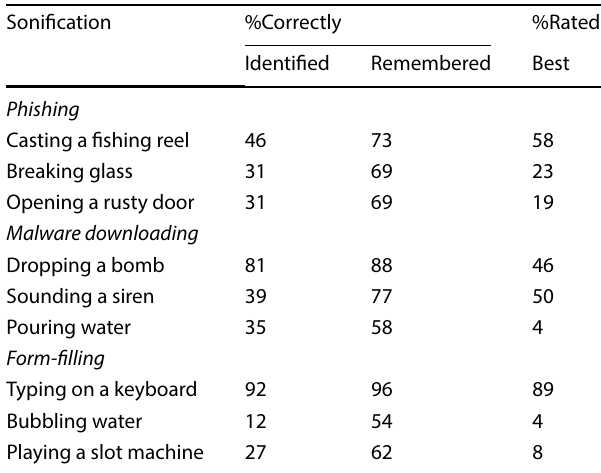
Table 5 Results of “out-of-context” study for participants who were not visually impaired